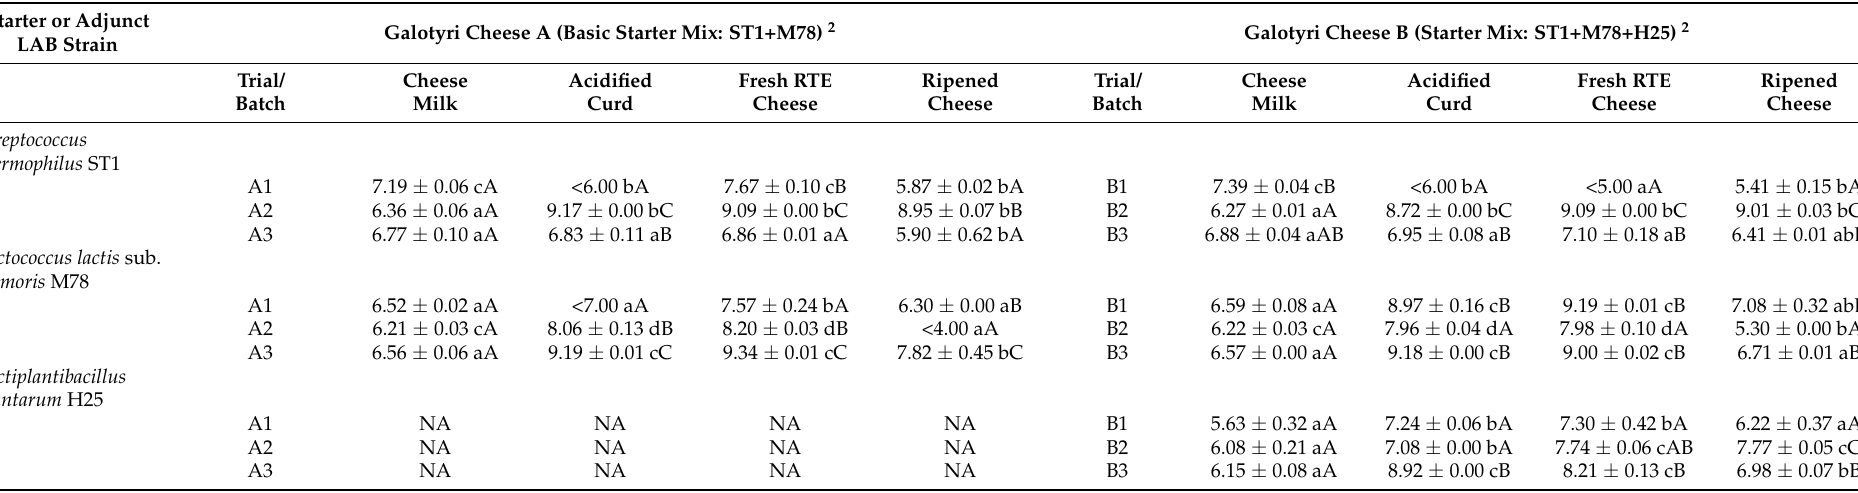
processing steps according to the artisanal Galotyri cheese processing protocol illustrated in Figure 1 and explained in Section 2.2. NA: not applicable; ST1 +M78: S. thermophilus ST1+ Lc. lactis subsp. cremoris M78; ST1+M78+H25: S. thermophilus ST1+ Lc. lactis subsp. cremoris M78+ L. plantarum H25. Table 2. Populations (log CFU/g) of autochthonous enterococci and non-LAB spoilage bacteria and yeast contaminating biota, selectively enumerated